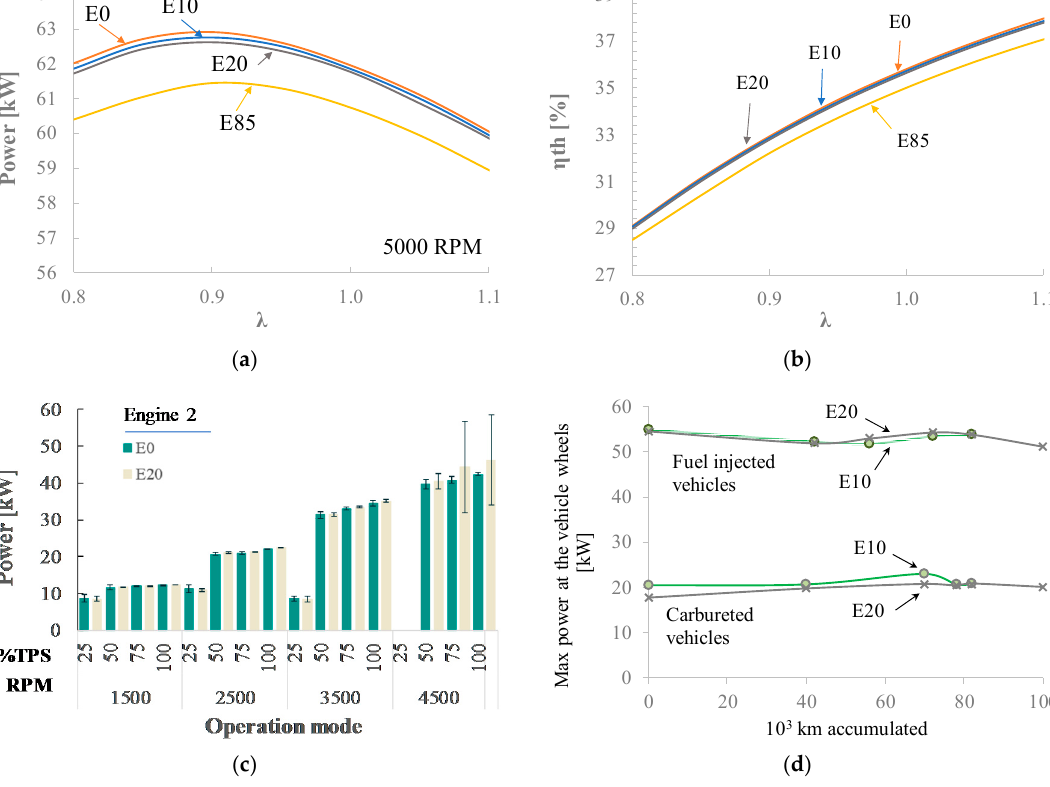
Figure 2. Power generated by engines when they operate with ethanol-gasoline blends. ( a ) Estimated power at 5000 RPM and ( b ) Estimated thermal efficiency displayed by engine 2 as a function of λ and ethanol content in the fuel; ( c ) Measured power delivered by engine 2 under steady-state conditions and different modes of operation; ( d ) Measured maximum power delivered by carbureted vehicles and fuel-injected vehicles after each ~10,000 km of operation.